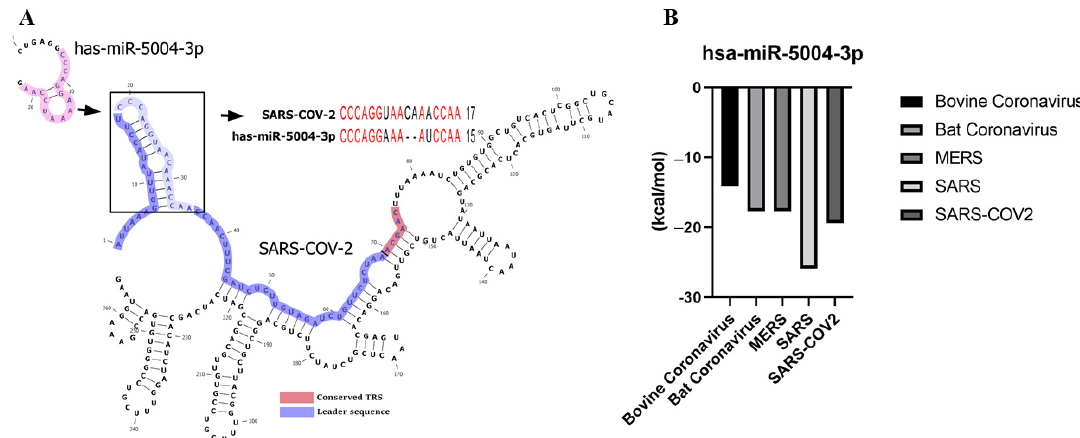
Figure 4. ( A ) hsa-miR-5004-3p is the only human microRNA able to target the leader sequence of SARS-CoV-2. ( B ) Binding Figure 4. ( A ) hsa − miR − 5004 − 3p is the only human microRNA able to target the leader sequence of SARS − CoV − 2. ( B ) Bind- ing energy (Kcal/mol) between leader sequence of coronaviruses and hsa − miR − 5004 − 3p. Lower binding energies (smaller energy (Kcal/mol) between leader sequence of coronaviruses and hsa-miR-5004-3p. Lower binding energies (smaller values) values) demonstrate higher binding stability between microRNA and leader sequence. demonstrate higher binding stability between microRNA and leader sequence.